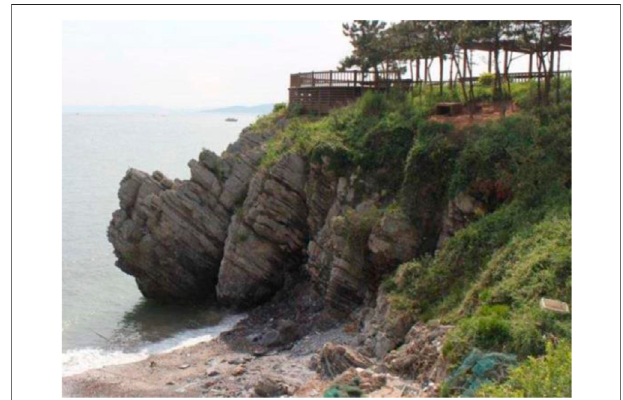
FIGURE2| Geometryandboundaryconditionsofthebasicmodelused in this work (Length unit: m).